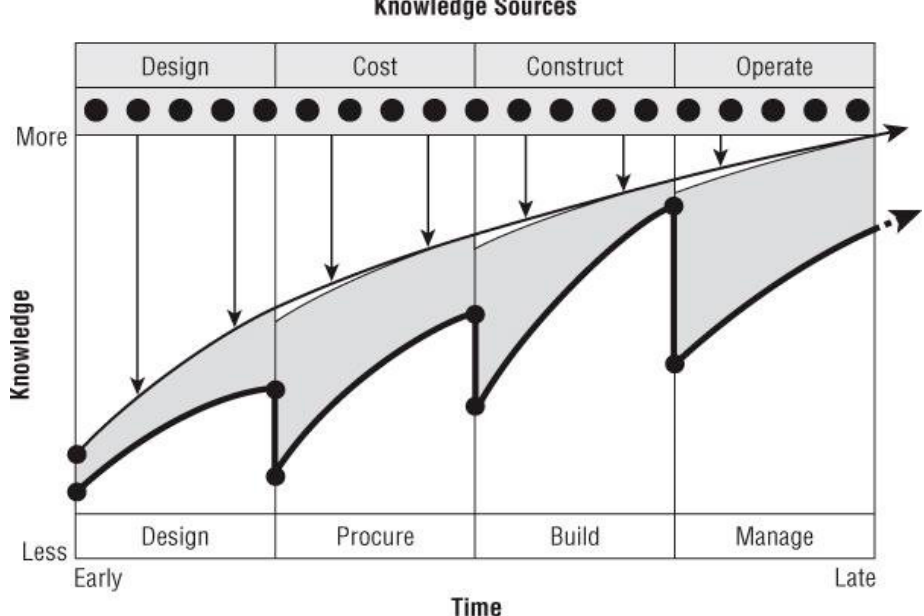
Figure 1. The BIM curve shows data loss without interoperability at project milestones (After: